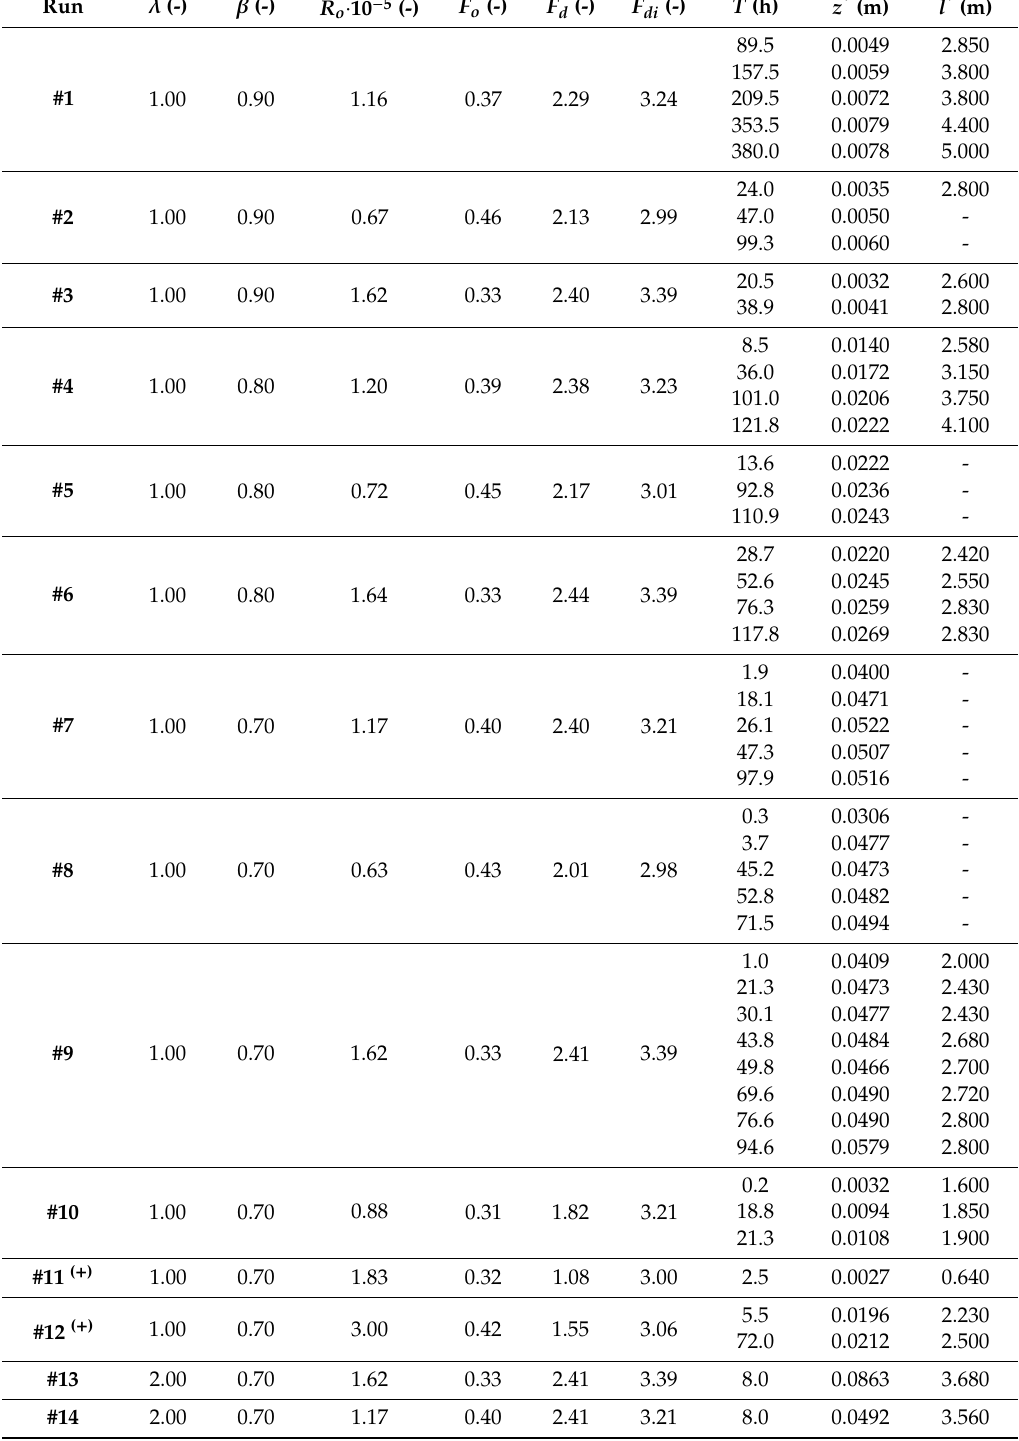
Table 1. Test conditions and peculiar characteristics of the bed